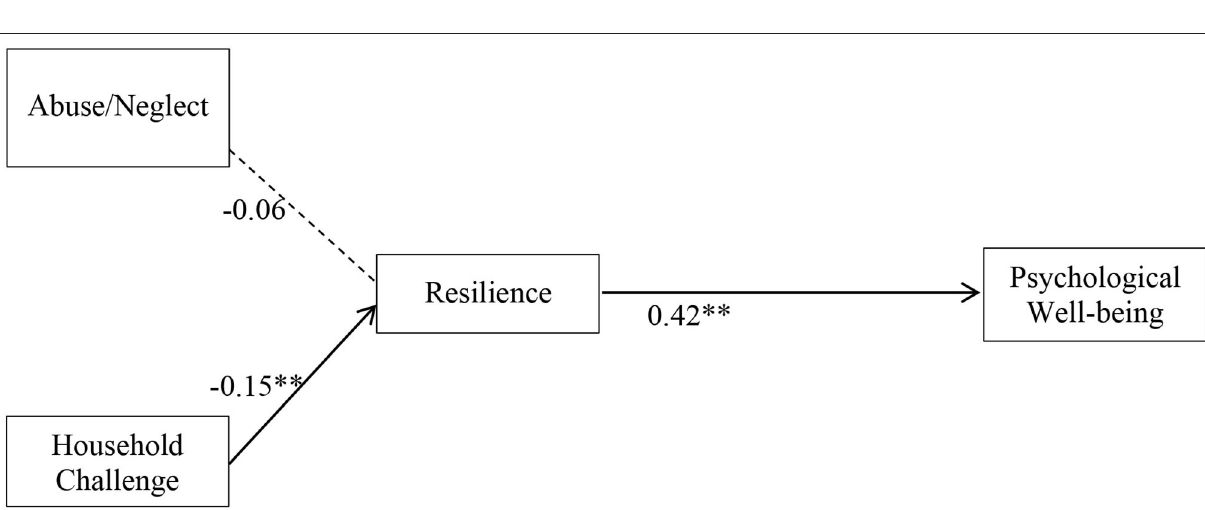
well-being ( β = 0.60, p < 0.001). Household challenges